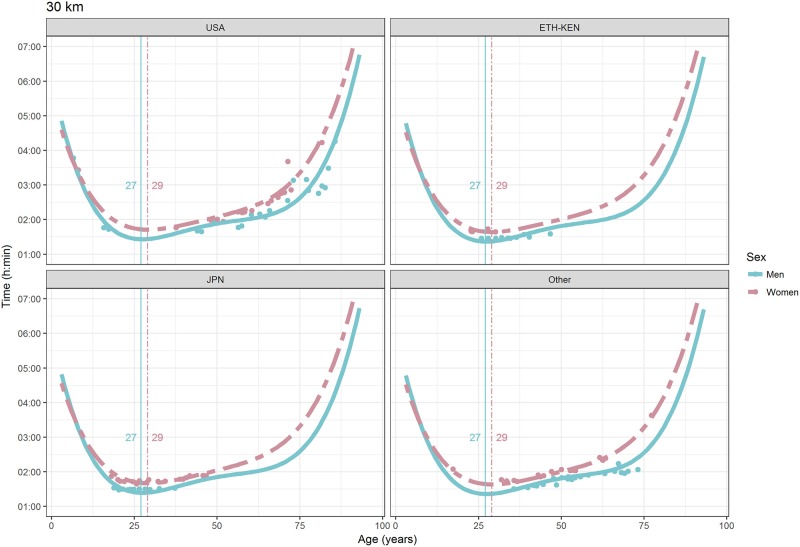
World record in 30 km by sex, age (in years), and country. Points were observations. Curves represented quartic degree polynomial regression. Vertical lines with numeric labels were the ages at peak performance.